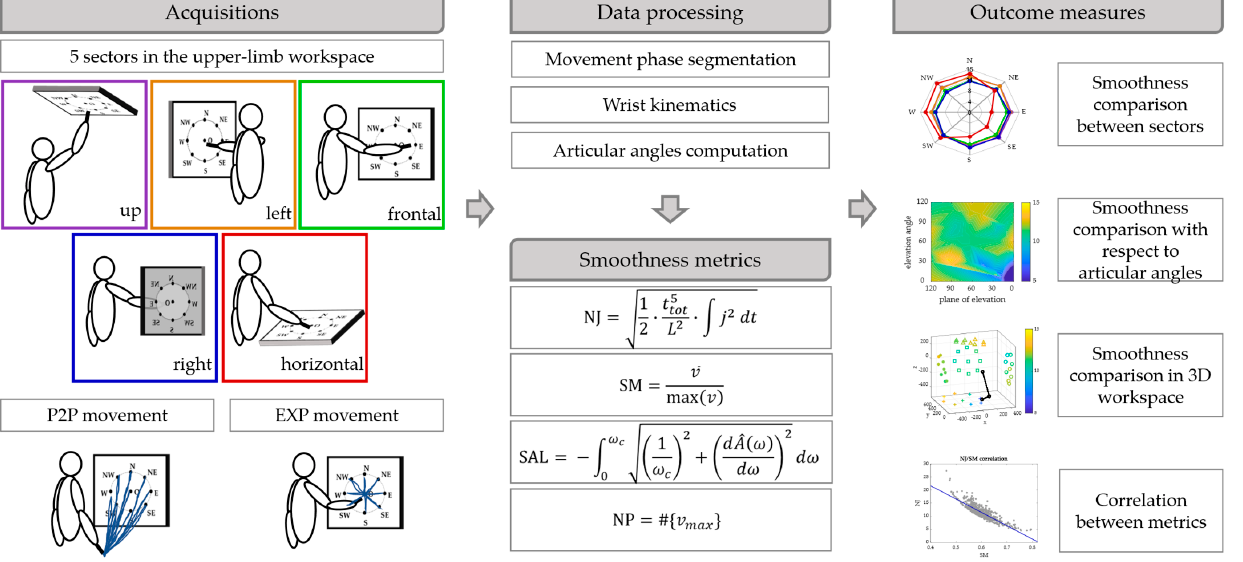
Figure 1. Scheme of the work. Upper limb movements (P2P and EXP) were performed in 5 sectors of the workspace by 15 subjects. The data were segmented in phases and the wrist kinematics and the articular angels were computed. Then, four smoothness metrics based on wrist motion were computed and smoothness was compared between sectors, mapped with respect to articular angles and in the 3D workspace for each of the smoothness metric. Finally, the correlations between pairs of metrics were